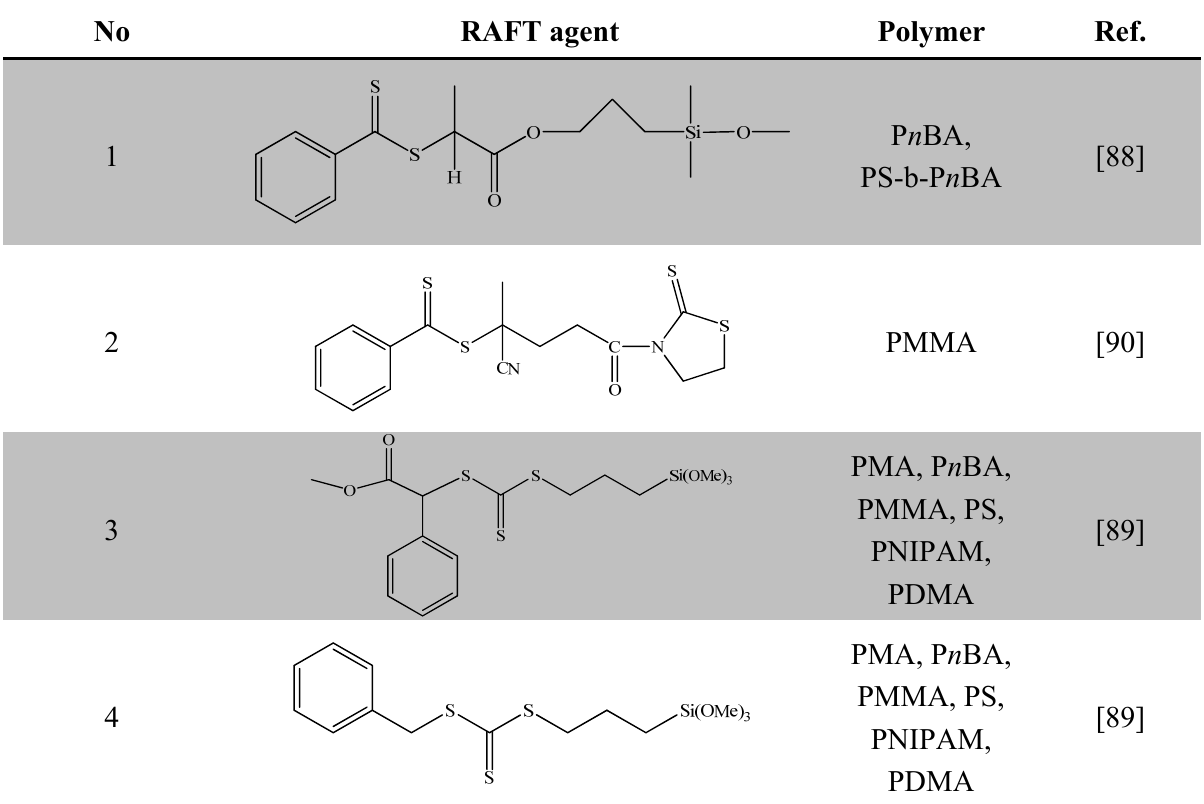
Table 2. RAFT agents bound on silica nanoparticles (R-group